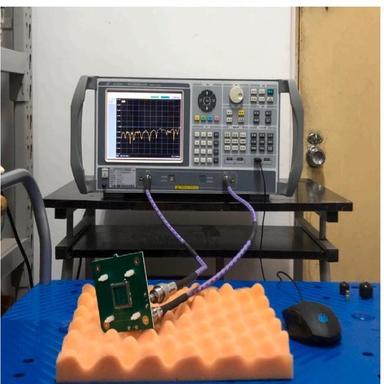
VNA-based actual measurement setup.